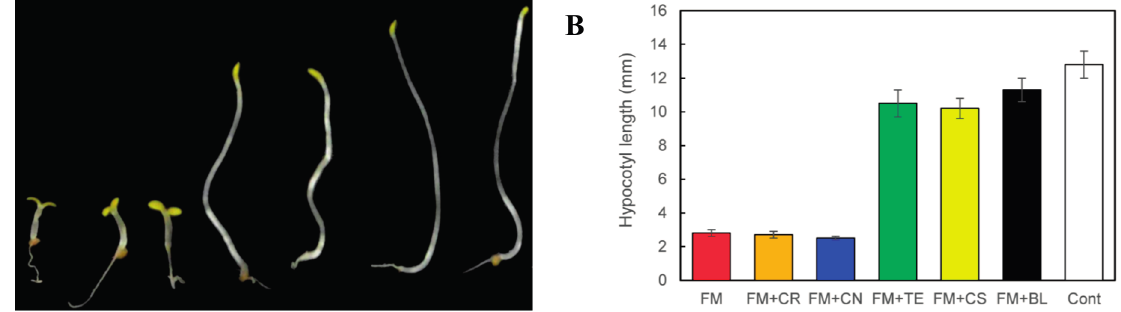
Figure 6. Responses of Arabidopsis seedlings to FM treatments and BL and BR biosynthesis intermediate complementation. Wild-type (Col-0) plants grown on ½ MS media containing designed chemicals in the dark for 5 days. The plants shown are as follows: plant grown in 10 μ M FM (the plant on the left); plant treated with 10 μ M FM and co-application of 100 μ M CR (the second plant from the left); plant treated with 10 μ M FM and co-application of 100 μ M CN (the third plant from the left); plant treated with 10 μ M FM and co-application of 100 μ M TE (the plant in the middle); plant treated with 10 μ M FM and co-application of 100 nM CS (the third plant from the right); plant treated with 10 μ M FM and co-application of 10 nM BL (the second plant from the right); and the plant without chemical treatment (the plant on the right). ( B ) The hypocotyl length of corresponding plants as shown in ( A ) ( n > 15). Data are the means ± S.E. obtained from 15 to 20 plants. All of the experiments were duplicated to establish